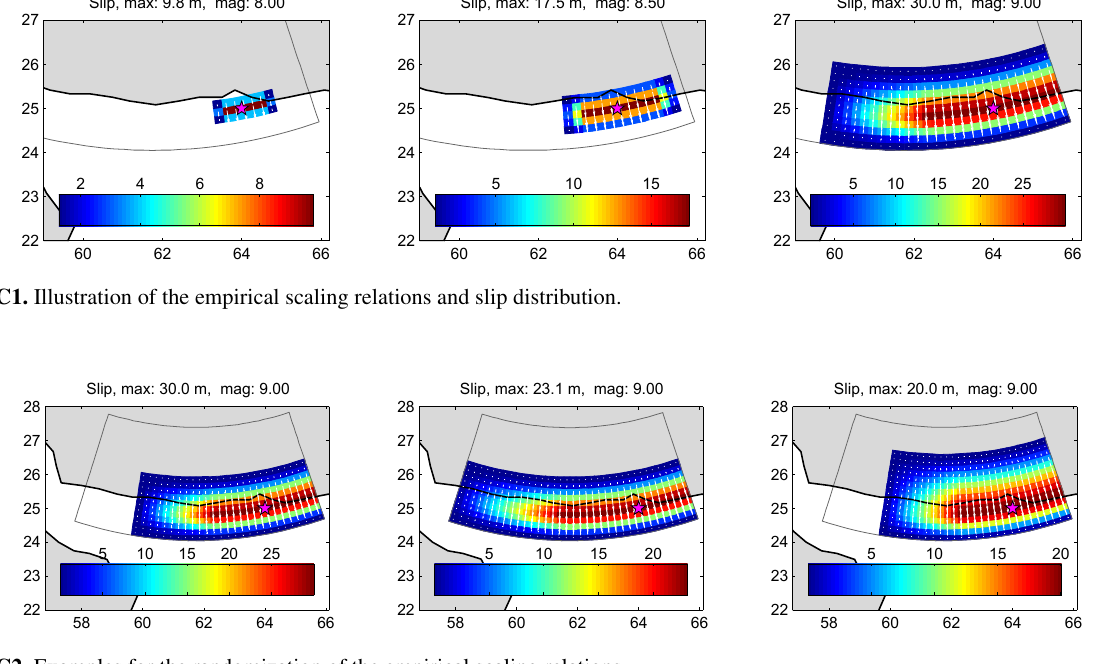
Figure C2. Examples for the randomization of the empirical scaling